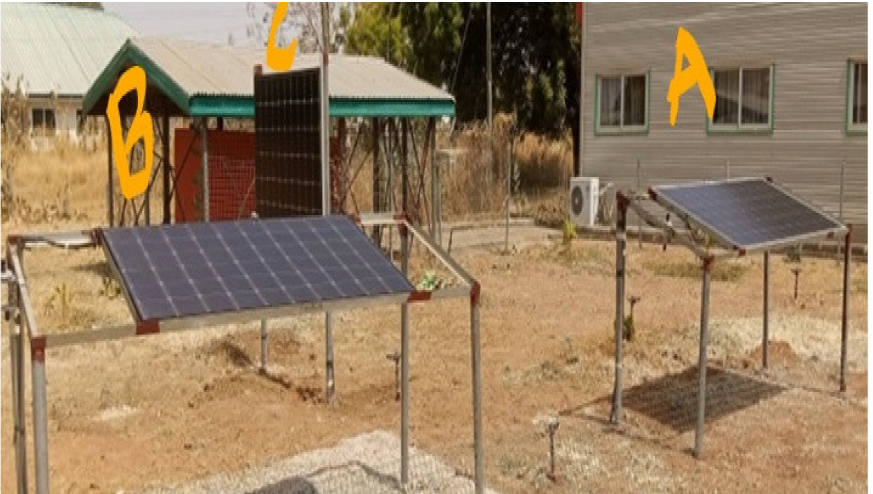
Figure 1. Site installation at Navrongo, Ghana [Inclined Monofacial PV module (Panel A), Inclined